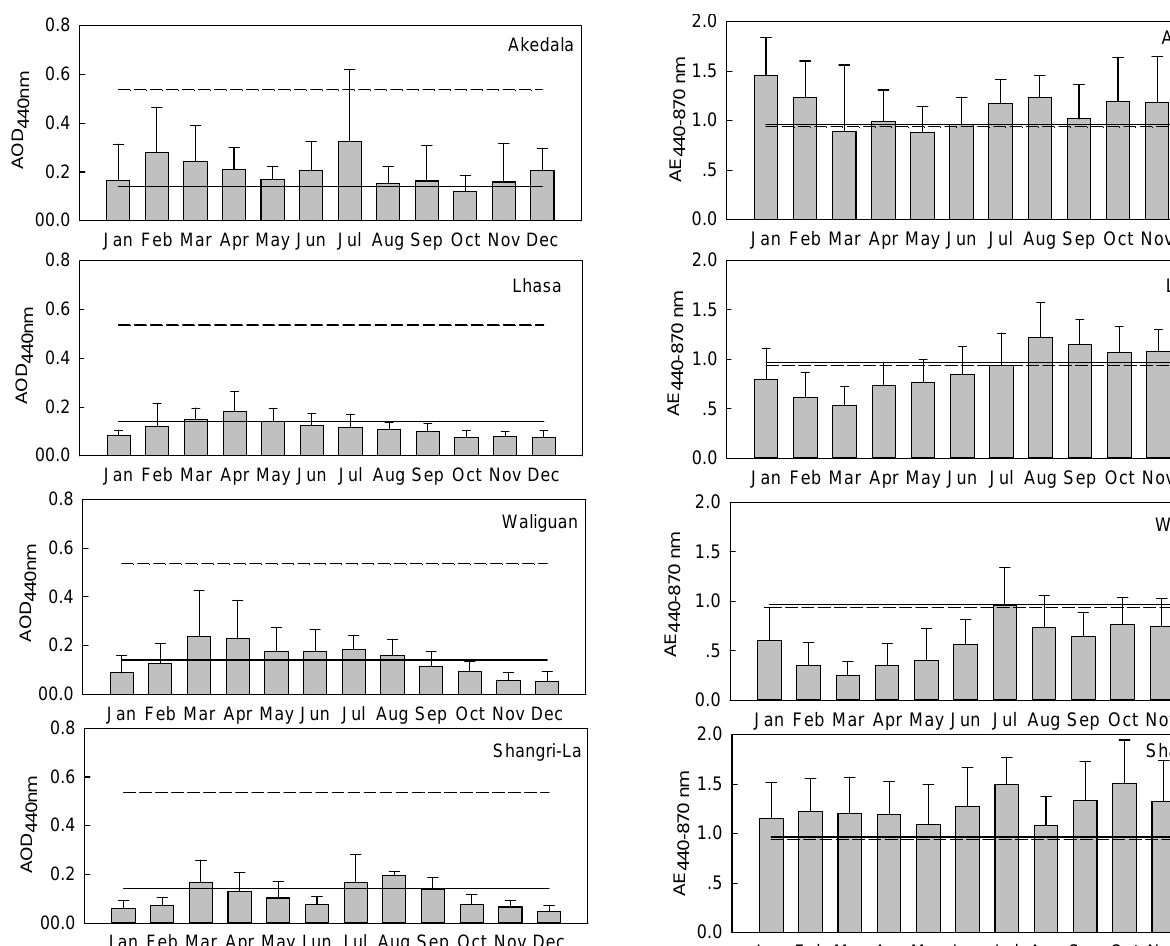
However, the AEs in fall and winter were factors of 1.27,